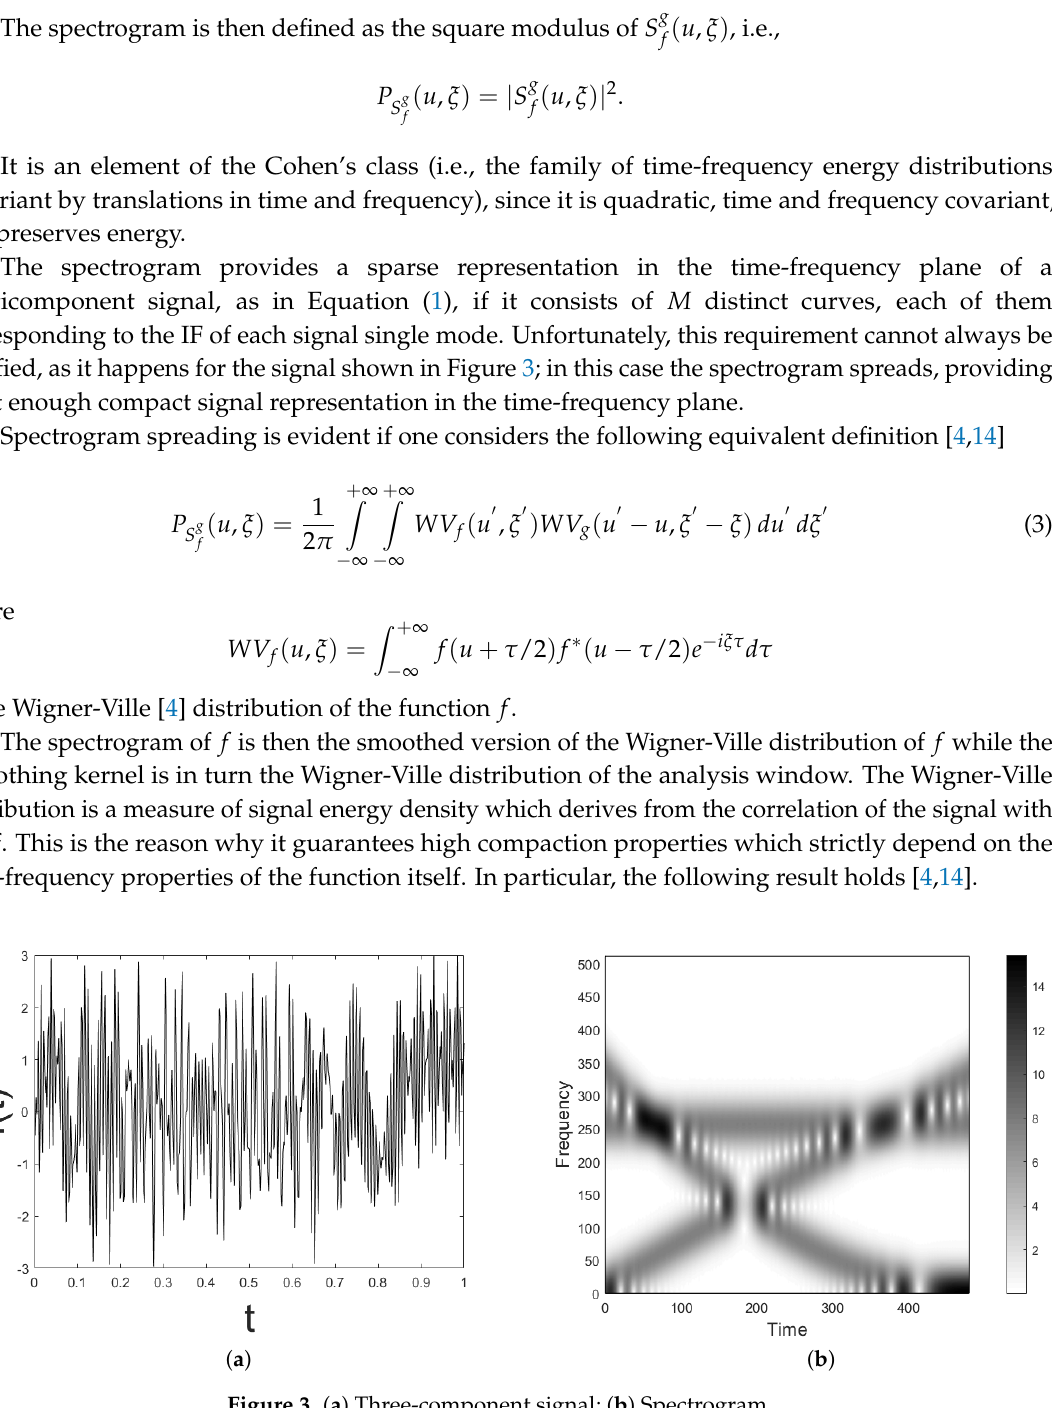
Figure 3. ( a ) Three-component signal; ( b )